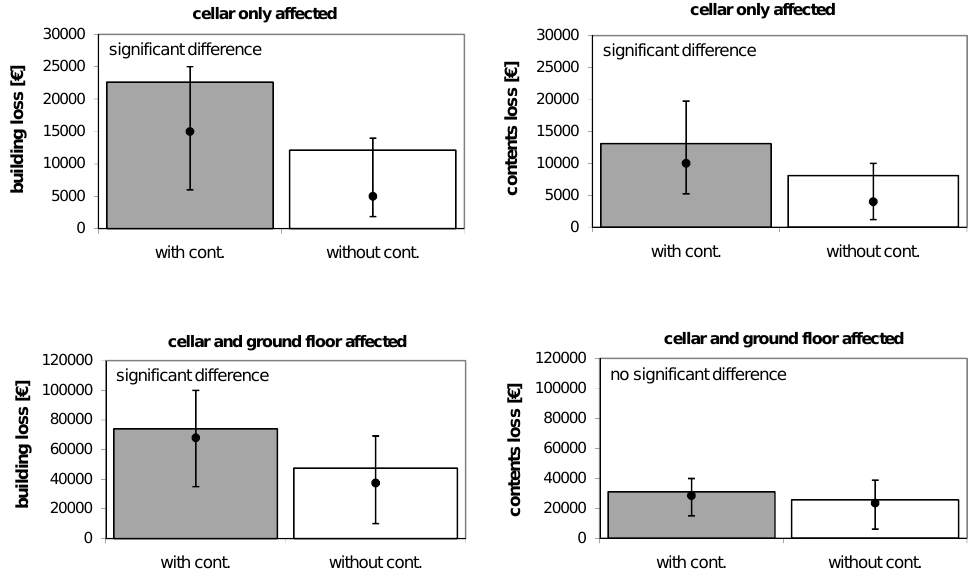
Fig. 5. The influence of oil contamination on building and contents damages, separated into cases where only cellars were affected and cases where ground floors were affected as well (bars=means, points=medians and 25–75% percentiles, significant differences between the cases with/without contamination are indicated).